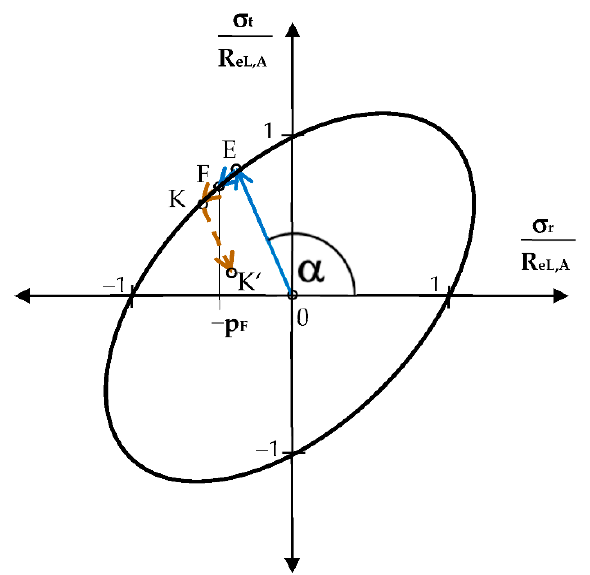
Figure 1. Principal stresses at the inner diameter of the outer part of an interference fit with an ideal plastic yield strength (GEH).